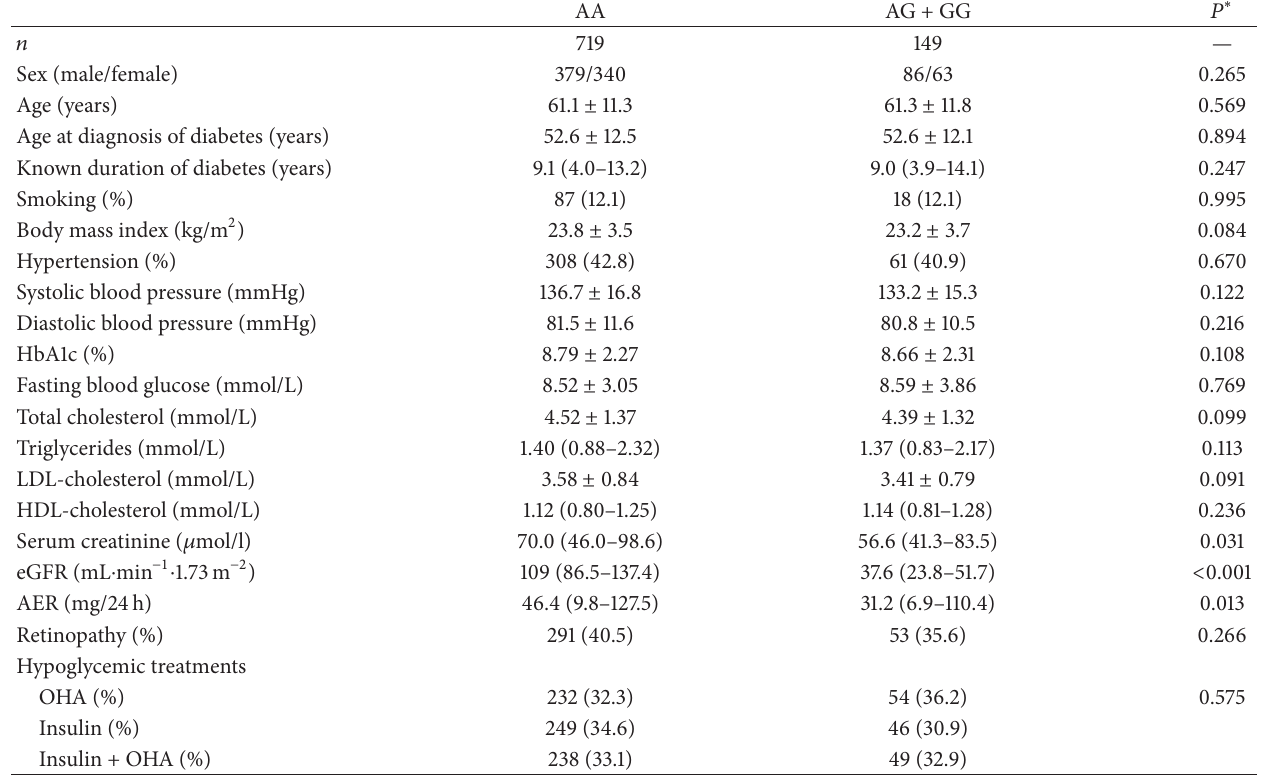
Table 2: Clinical and laboratory characteristics of patients with type 2 diabetes classified according to their 2184A/G genotypes.